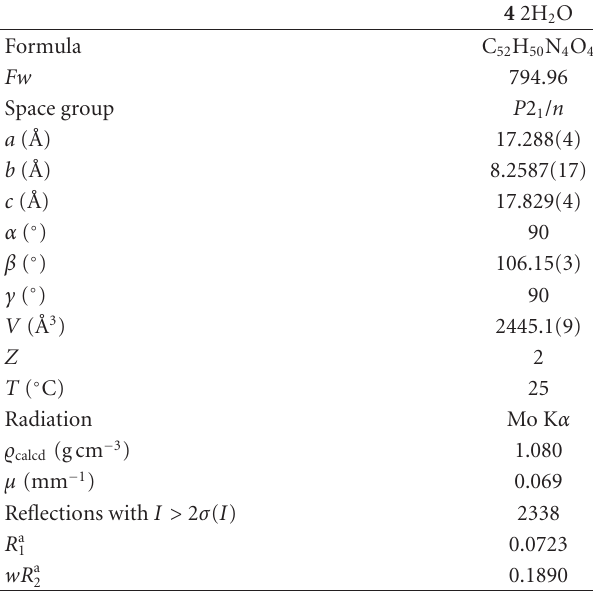
signal for each group. The hydrolysis product 5 the o -H are no longer equivalent resonating at 7.82 ppm and 7.70 ppm.